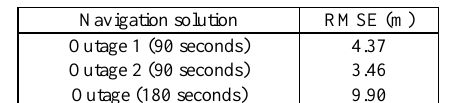
Table 4. Position RMSE for modified 3D RISS with steering angle navigation solution method for different GNSS signal